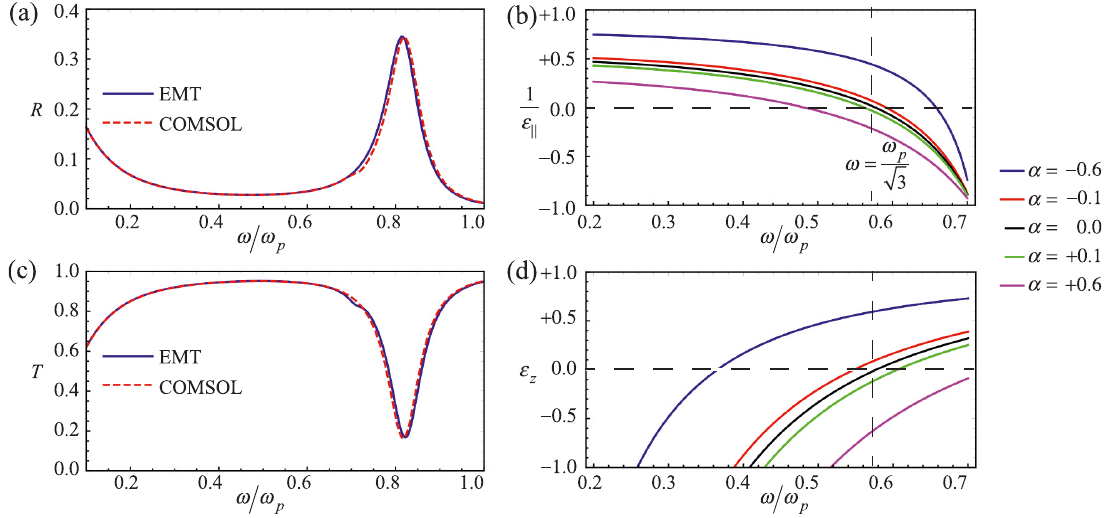
Figure2: (a)Reflectionfromand(c)transmissionthroughoneunitcellof ananowiremetamaterial withperiod10 nmand fi lling ratio f m =1/3, calculated with effective medium theory (EMT) theory and COMSOL. The incident angle is at 45 ° to the z -axis, and the electric fi eld has both E z and E x components. The magnetic fi eld has only a H y component. (b) 1 / ε ∥ for various − 0.6 < α < 0.6, plotted against ω / ω p . (d) ε z for various − 0.6 < α <